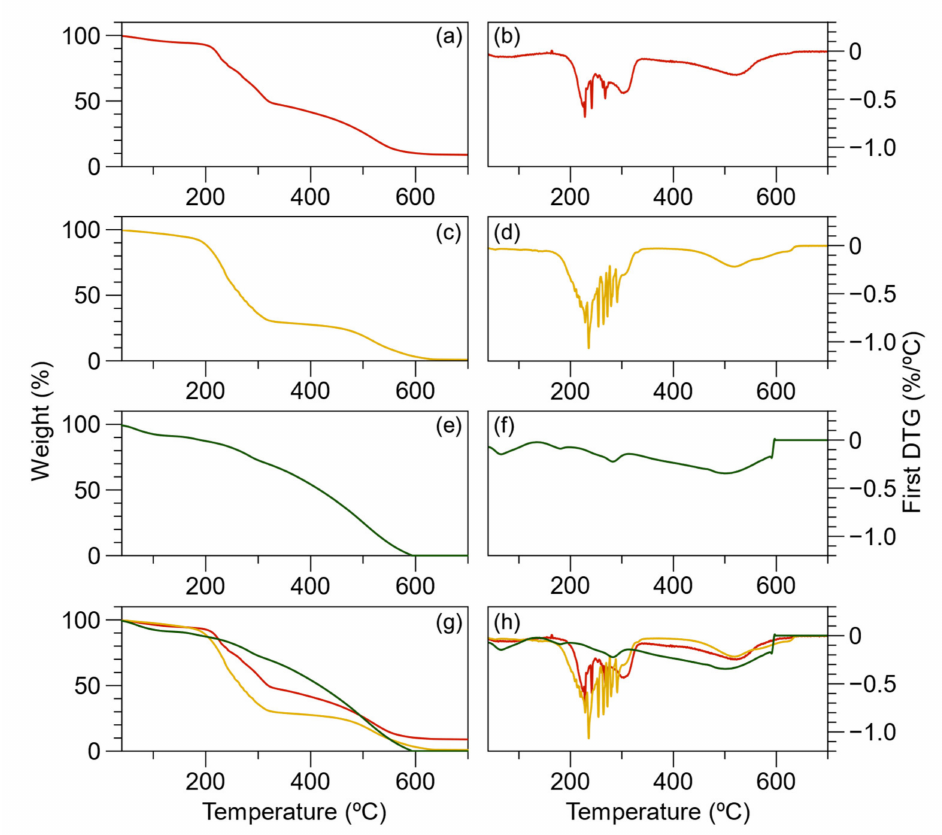
Figure 9. ( a ) Thermogram and ( b ) First derivative (DTG) of macro-RAFT; ( c ) Thermogram and ( d ) DTG of PAAMP- b -PVK; ( e ) Thermogram and ( f ) DTG of PAAMP- b -PVK; ( g ) Thermogram and ( h ) DTG of macro-RAFT (red), PAAMP- b -PVK (yellow), and BL PAni